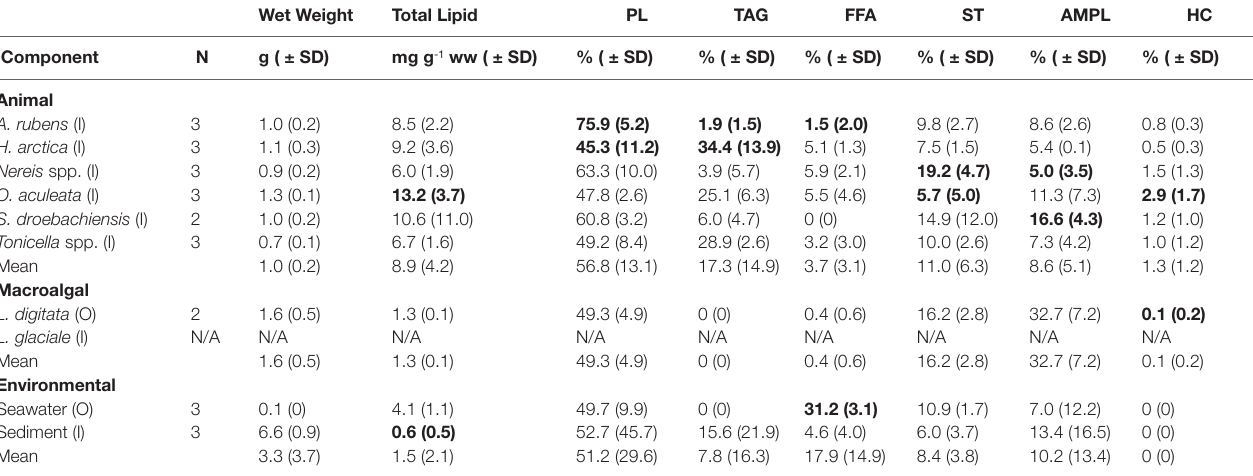
N/A Data not available. Each variable’s lowest and highest values are